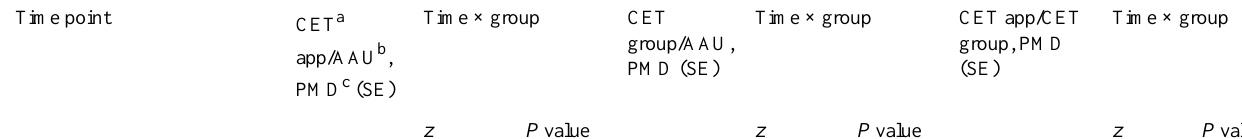
Table 3. Predicted mean differences of primary and secondary outcomes over time and by group